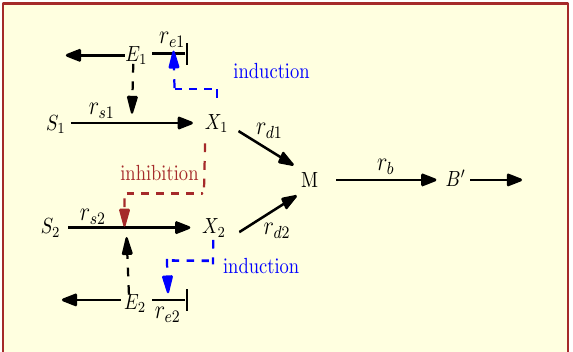
Figure 1. Reaction scheme for the diauxic growth network. S 1 , S 2 are the substrates, X 1 , X 2 are the intracellular metabolites, E 1 , E 2 are the enzymes, M is the intermediate metabolite, and B (cid:48) is the main Biomass. The reaction rates are indicated in (solid arrows), catalytic activities and regulatory interactions in (dashed